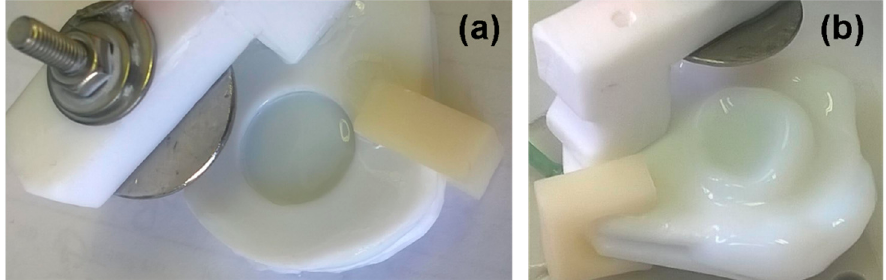
Figure 6. Picture of wet green bodies immediately after EPD in the case of ( a ) vertical and ( b ) hori- zontal deposition from YLO_i_1 suspension.